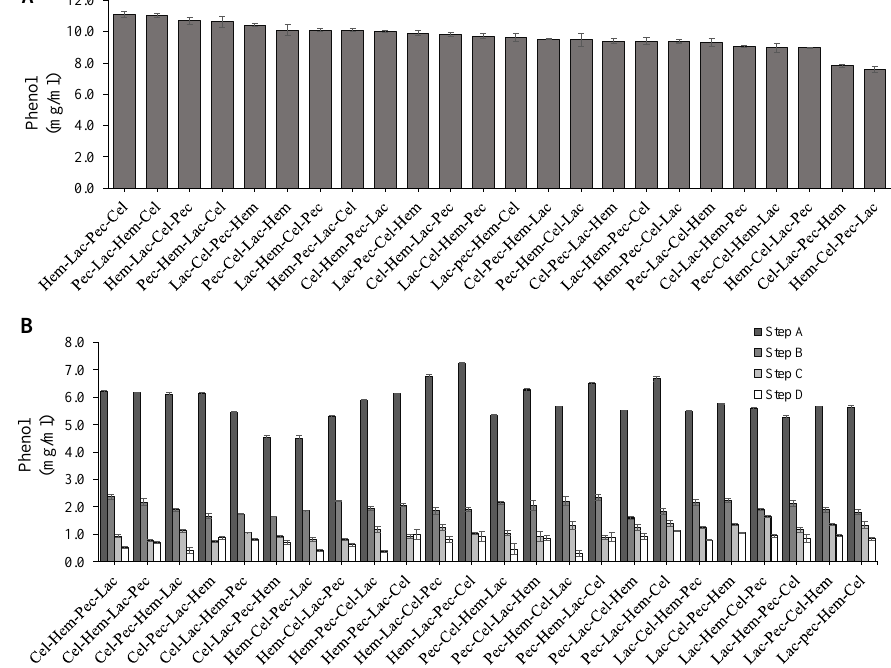
Figure 6. The effect of enzyme sequence action on the release of Phenol. ( A ) Total phenol production during four steps enzyme digestion for the corn stover (from the highest to the lowest). ( B ) Phenol production levels during four steps enzyme digestion. The error bars represent standard error of the mean ( n = 3).